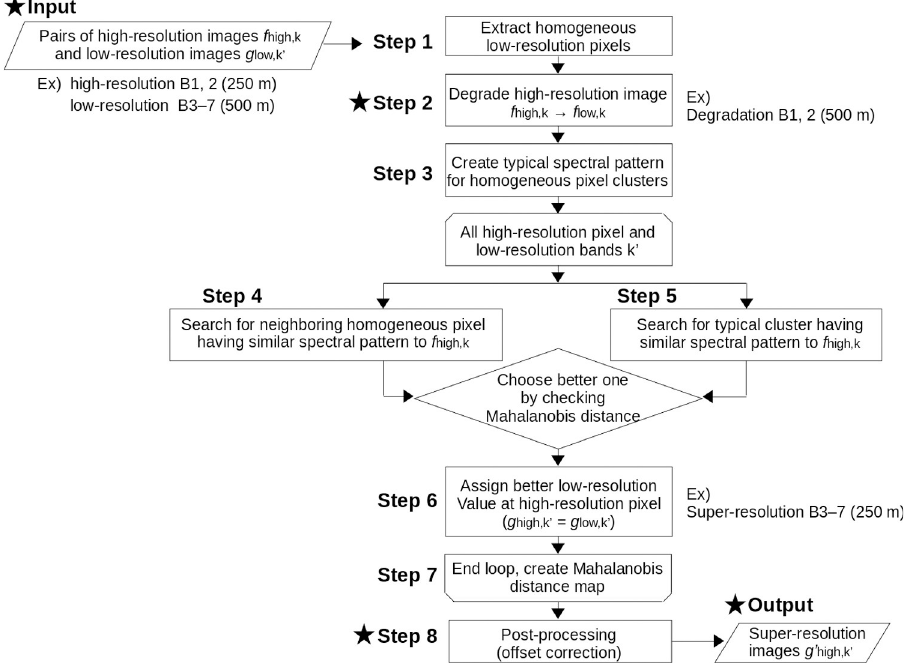
Fig 1. Flowchart for super-resolution process. The star symbols are where our refinement from the original algorithm [26] was implemented. As an example, the super-resolution process for converting MODIS 500-m resolution images (band 3–7) to 250-m resolution images is